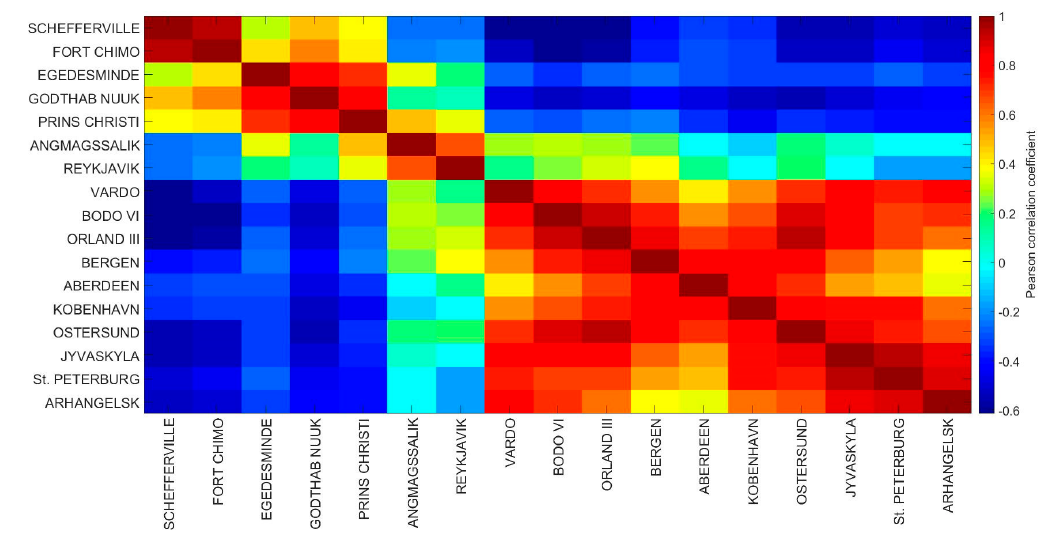
Figure A1. Pearson correlation coefficients among all weather stations in February (1951–2016 period).